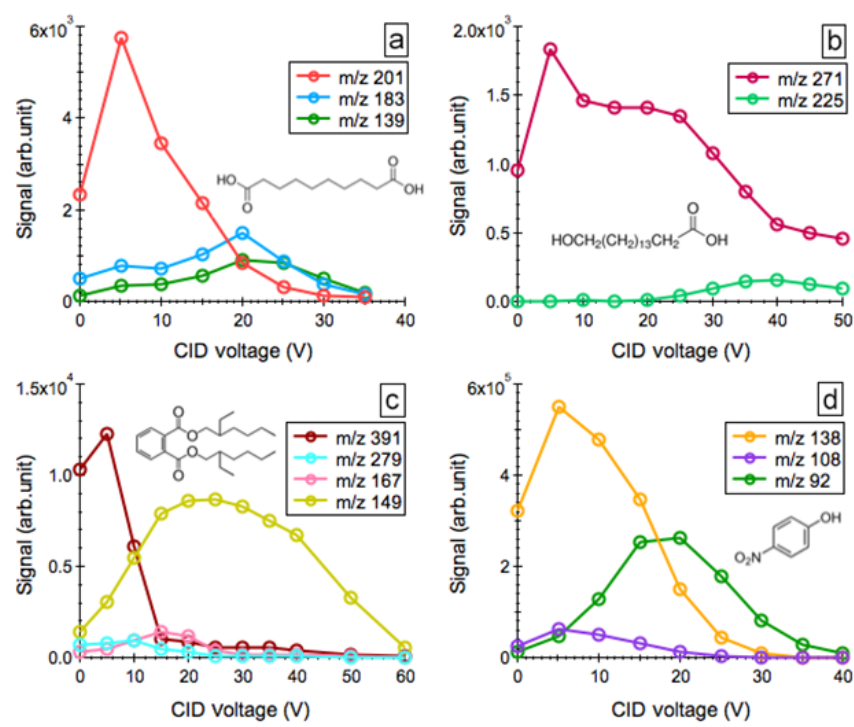
Figure 5. Precursor and product ion peak intensities as a function of collision voltage in the “mobility-selected” MS spectra of (a) deproto- nated sebacic acid, (b) deprotonated 16-hydroxyhexadecanoic acid, (c) protonated dioctyl phthalate, and (d) deprotonated